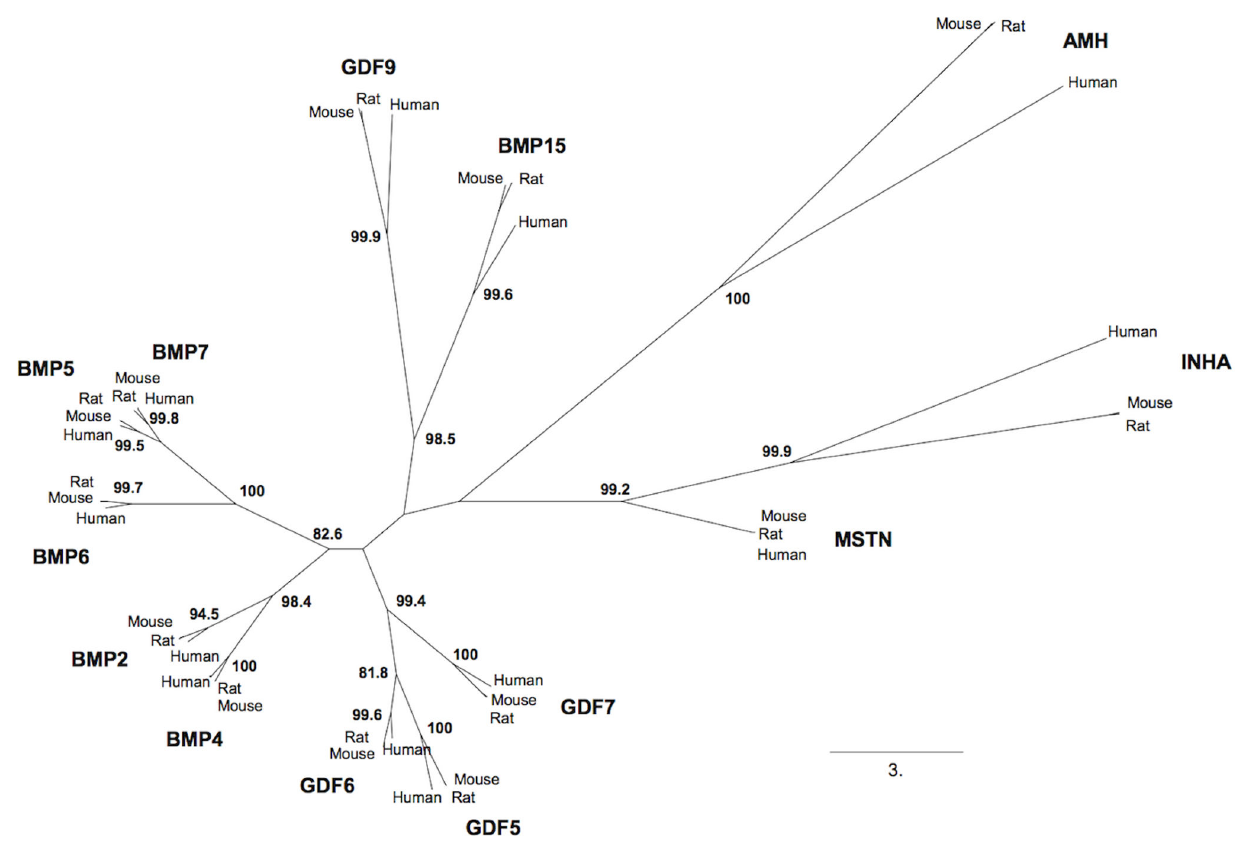
Figure 1. BMP15 evolution among TGFß/BMP family members. Phylogenetic tree of thirteen members of the TGFβ/BMP superfamily expressed by the mammalian ovary reconstructed using maximum likelihood. Bootstrap values are given when nodes are strongly supported (>80%). The scale represents the substitution